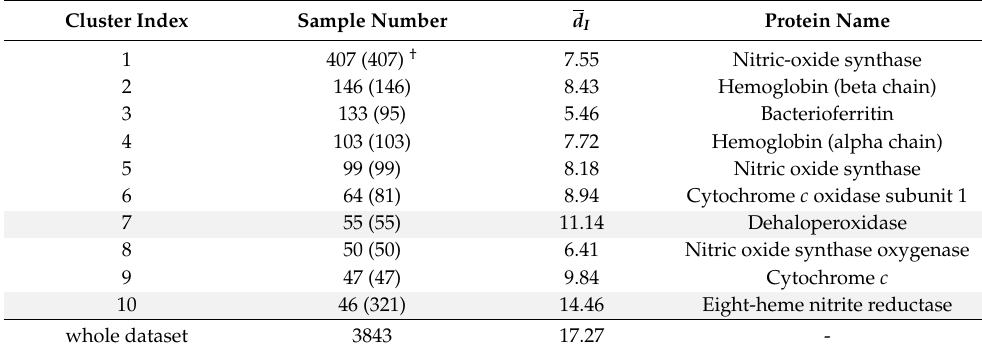
Table 5. The cluster indices, sample numbers, d I , and protein names of each cluster. The shaded rows represent the clusters with large d I .